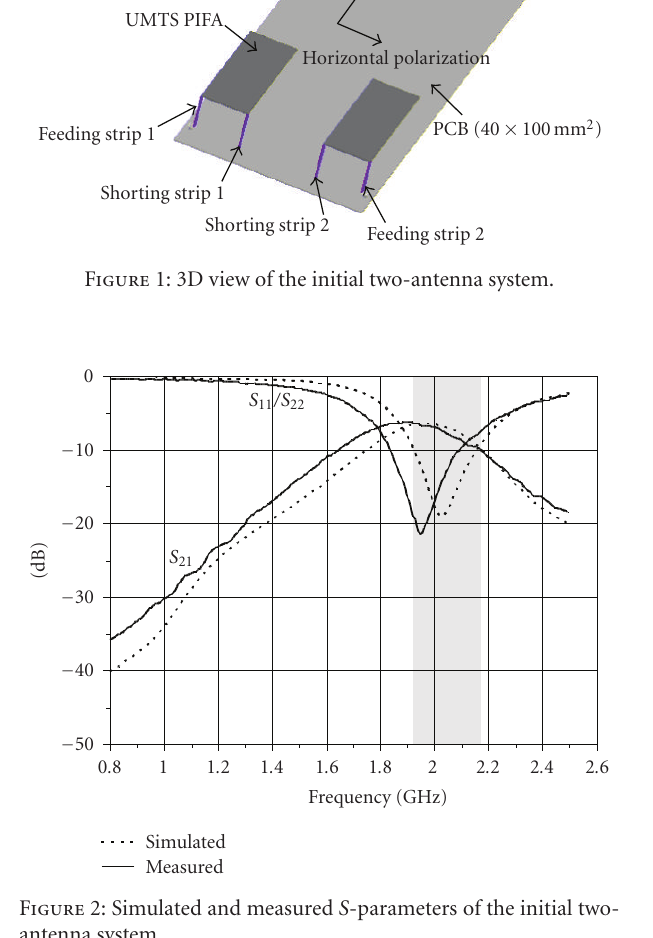
Figure 4: Simulated and measured S -parameters of the neutralized two-antenna